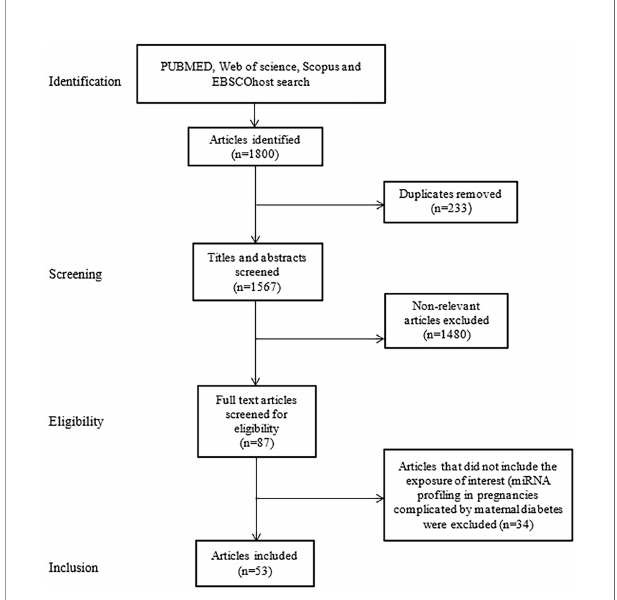
FIGURE 1 | Flow diagram showing selection of studies for inclusion in the